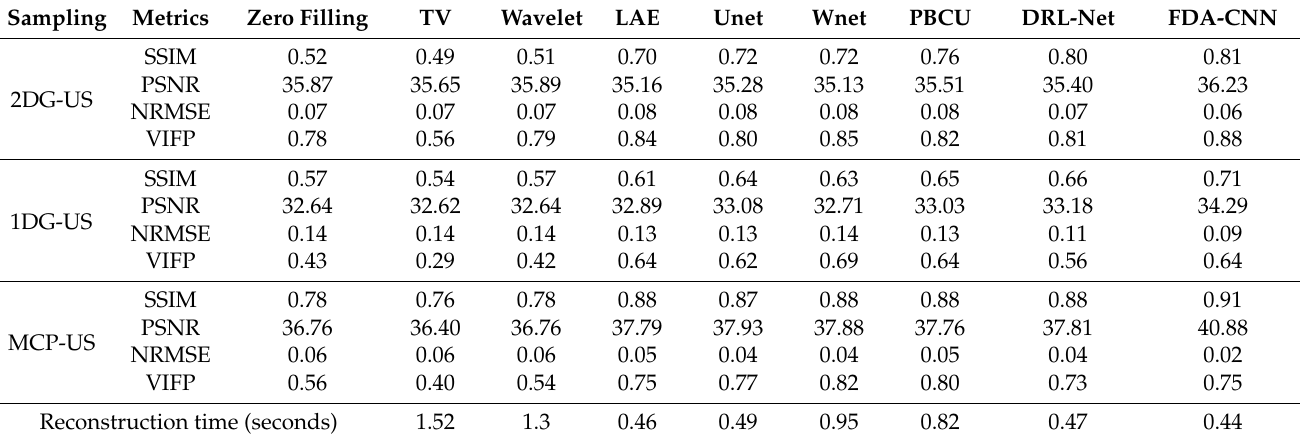
Table 2. Average SSIM, PSNR, NRMSE, and VIFP values and reconstruction time of state-of-art methods on fastMRI-T1 axial brain data using several sampling patterns.